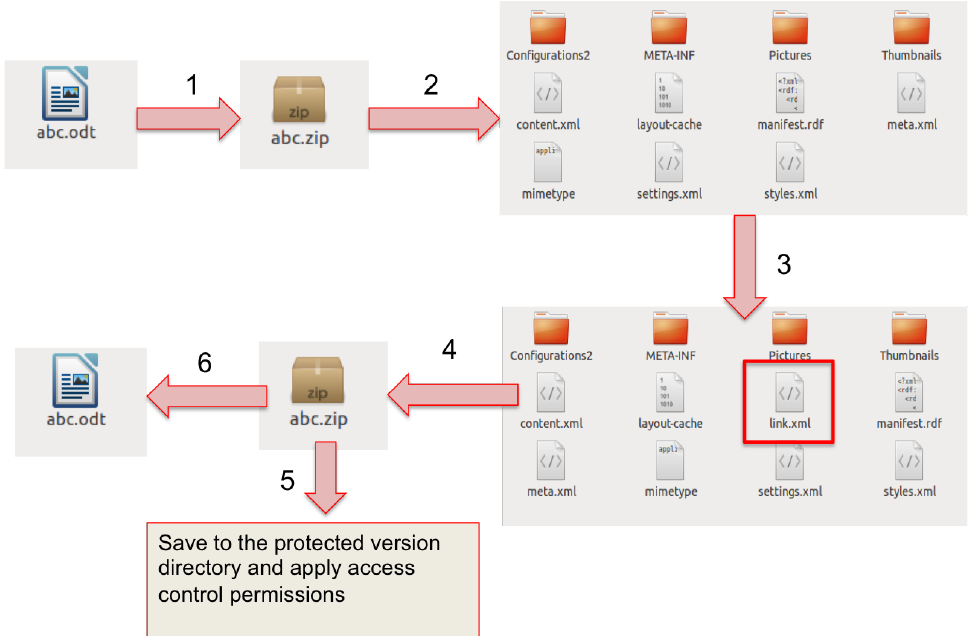
Figure 2. An illustrative example of the main steps of the version-control